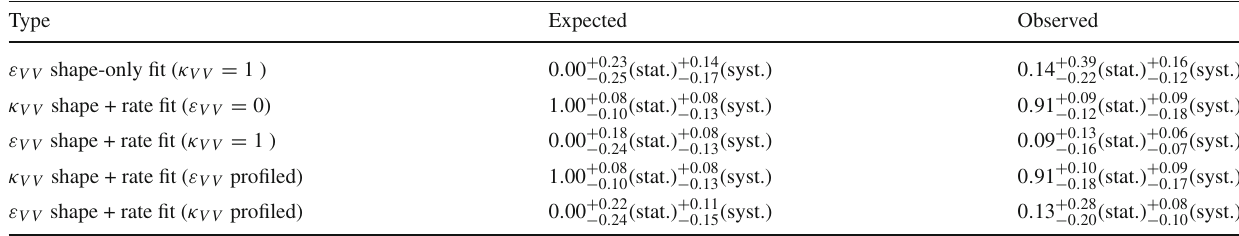
Table 10 Best-fit values and their uncertainties as obtained from the shape-onlyandshape-plus-ratelikelihoodfitstotheAsimovdatasetand to ATLAS data. Results of both shape-only and shape+rate fits for ε VV